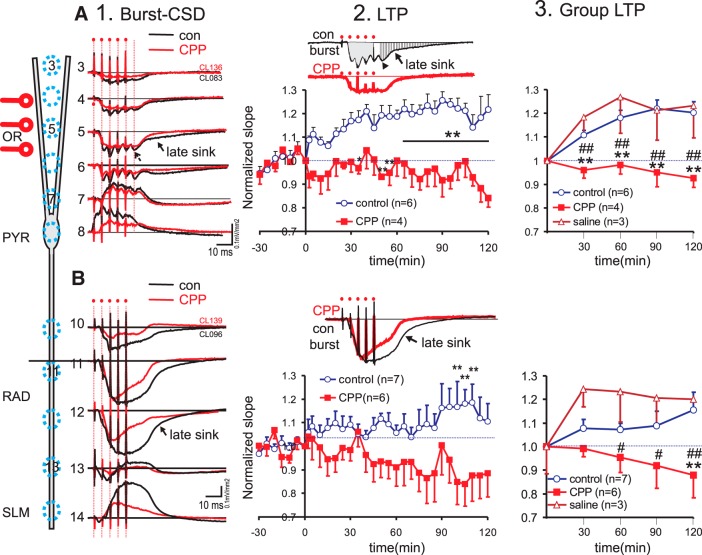
Effect of NMDA receptor antagonist CPP on dendritic bursts and burst-induced LTP induced during the rising phase of distal dendritic θ. A, Single burst stimulation (five pulses at 20-ms intervals, artifacts indicated by dots) of OR evoked a CSD profile of sustained basal dendritic sink at channel 3–6, accompanied by sources near pyramidal cell layer (PYR, channel 8). Profile for a rat after CPP diffusion is overlaid on that from a control (con) rat with no micropipette. At the maximal sink, the duration of the sink was prolonged in con compared to CPP rat (arrow in channel 5), and small spike-like sinks was observed (arrowhead). Column 2 inset shows early integrated sink as gray, and late integrated sink filled with vertical stripe. The time course of the mean ± SEM of the normalized sink slope was shown for the no-pipette control and CPP groups, indicating significant post hoc differences at specific time points. Column 3 shows mean ± SEM of burst-induced basal dendritic LTP in three groups of rats (with local micropipette containing CPP, with micropipette containing saline, or control without micropipette); LTP was averaged in blocks of 30 min (e.g., 90- to 120-min period labeled as 120 min). After a significant two-way ANOVA, post hoc comparisons between CPP and control (no pipette) groups: #p < 0.05, ##p < 0.01; CPP versus saline groups: *p < 0.05, **p < 0.01. B, Same as A except for the apical dendritic LTP following burst stimulation of RAD. Column 1, burst evoked CSDs show sustained apical dendritic sinks in RAD, accompanied by source in SLM. No PSs are obvious during the bursts in control or CPP rat, while the late sink amplitude and sink duration (arrow) were reduced in CPP as compared to control rat. Columns 2 and 3, Apical dendritic LTP was suppressed by CPP as compared to controls.